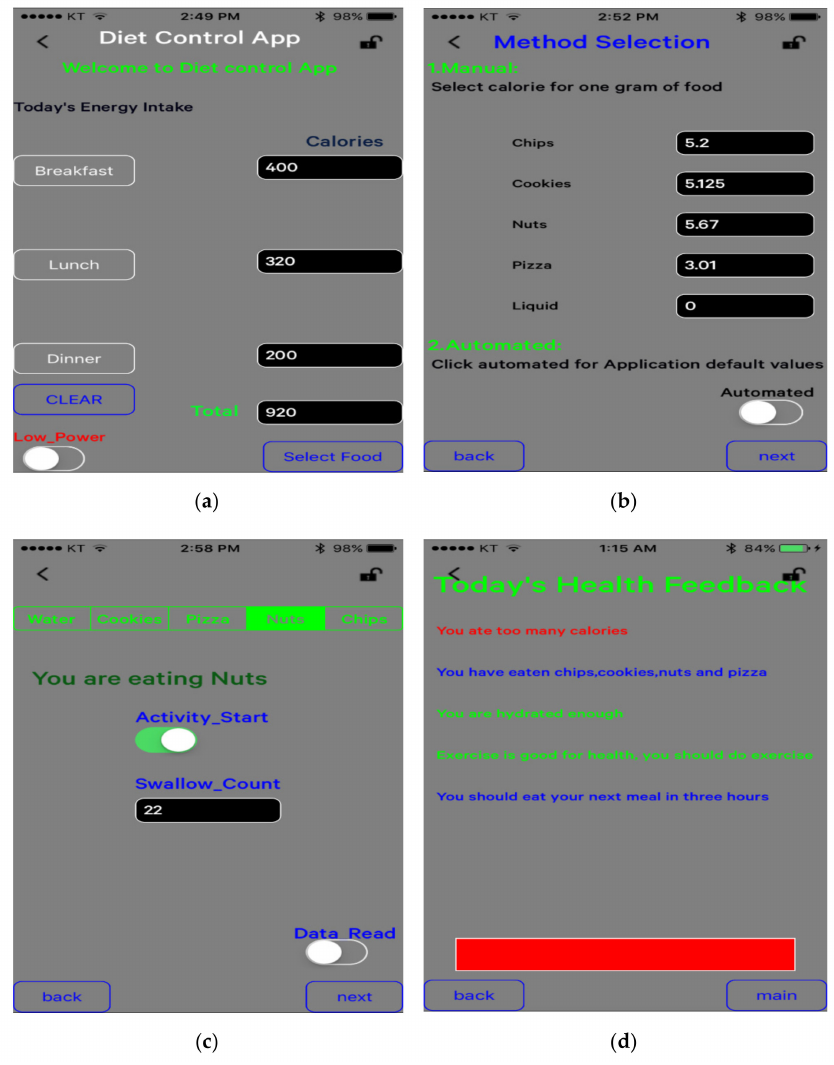
Figure 2. Smartphone application for food intake monitoring: ( a ) Caloric intake statistics; ( b ) Calorie method selection; ( c ) Swallow detection for each food category; ( d ) Health feedback for friendly suggestions.